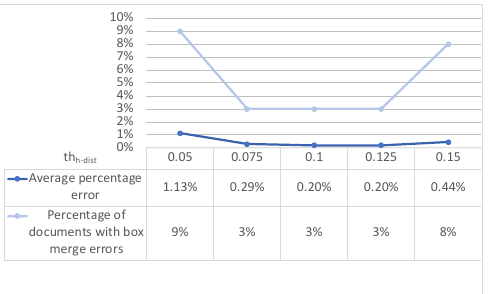
Figure 9. Text-region merging: effect of horizontal-distance threshold th h-dist .